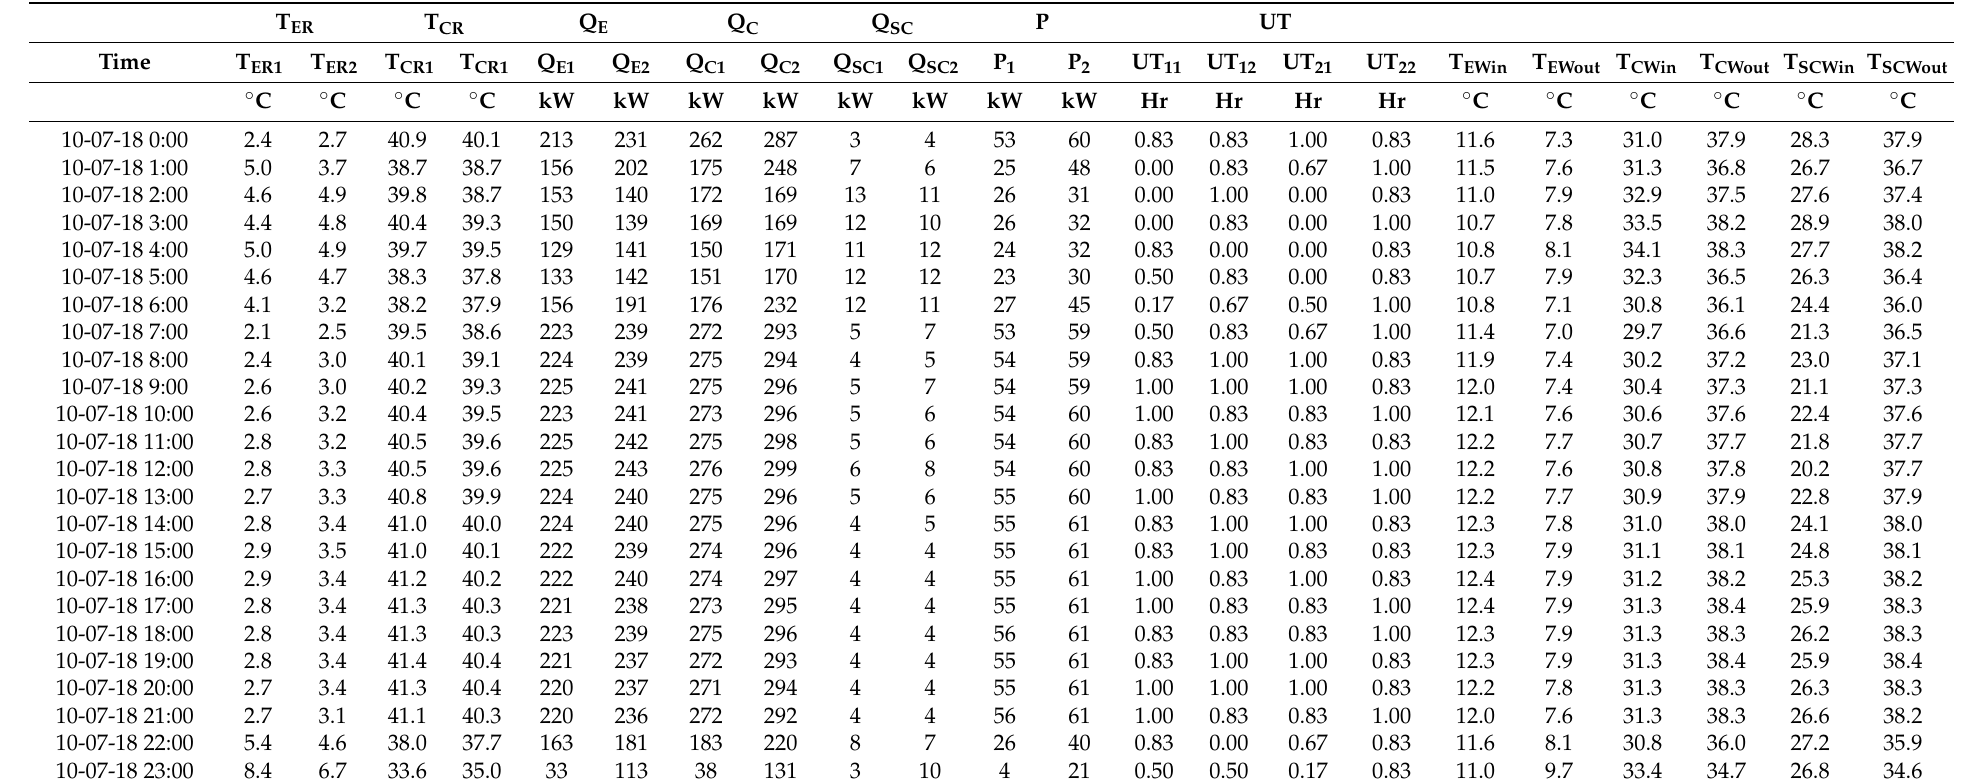
Table A5. Sample data from HP2 for a typical summer